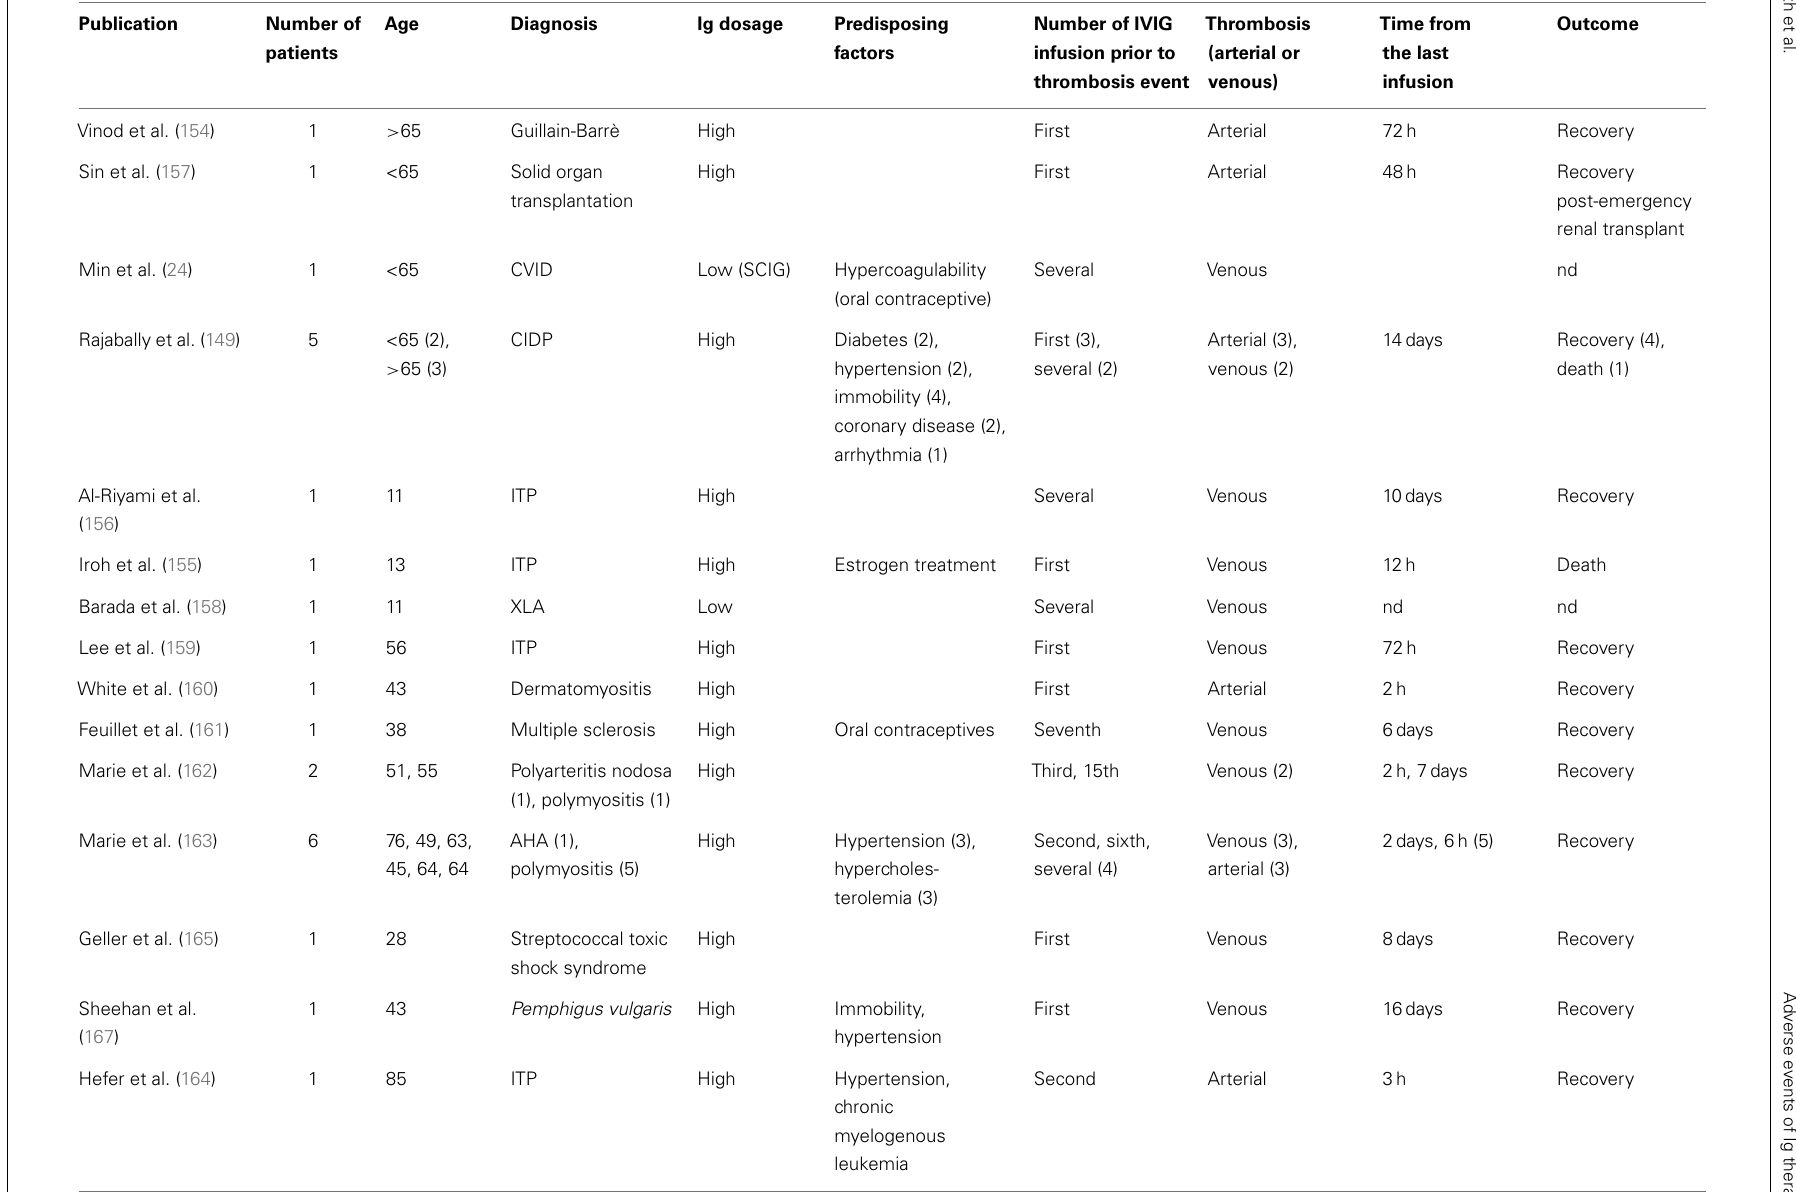
Table 3 | Falling into a deep lunar crater – Ig-induced thrombosis in recipients of polyvalent immunoglobulins